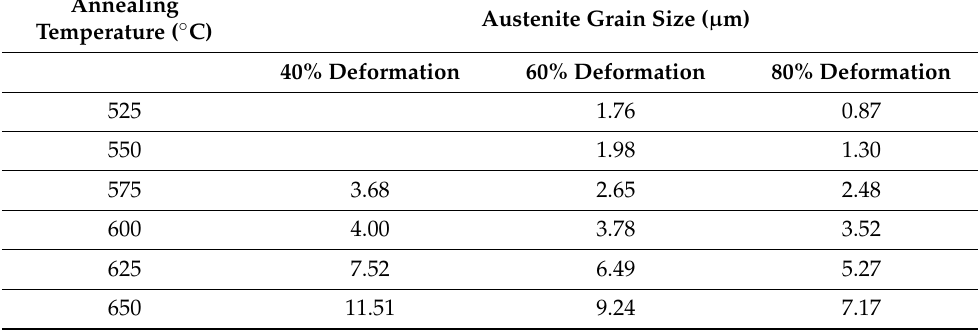
Table 3. Austenite grain size ( µ m) for 40%, 60% and 80% cold-deformation after 24 h annealing at different